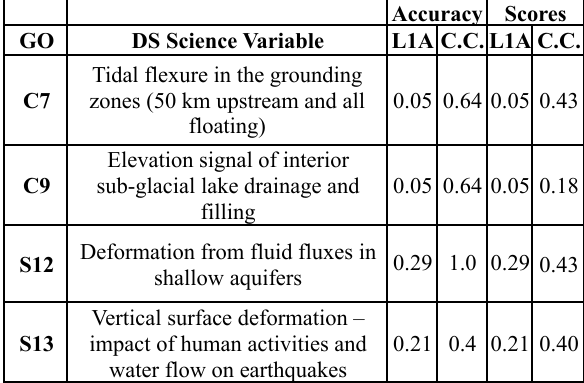
Table 7. Comparative assessment of scores for the L1A architecture and commercial constellations (C.C.) for the GOs that do not follow the logarithmic